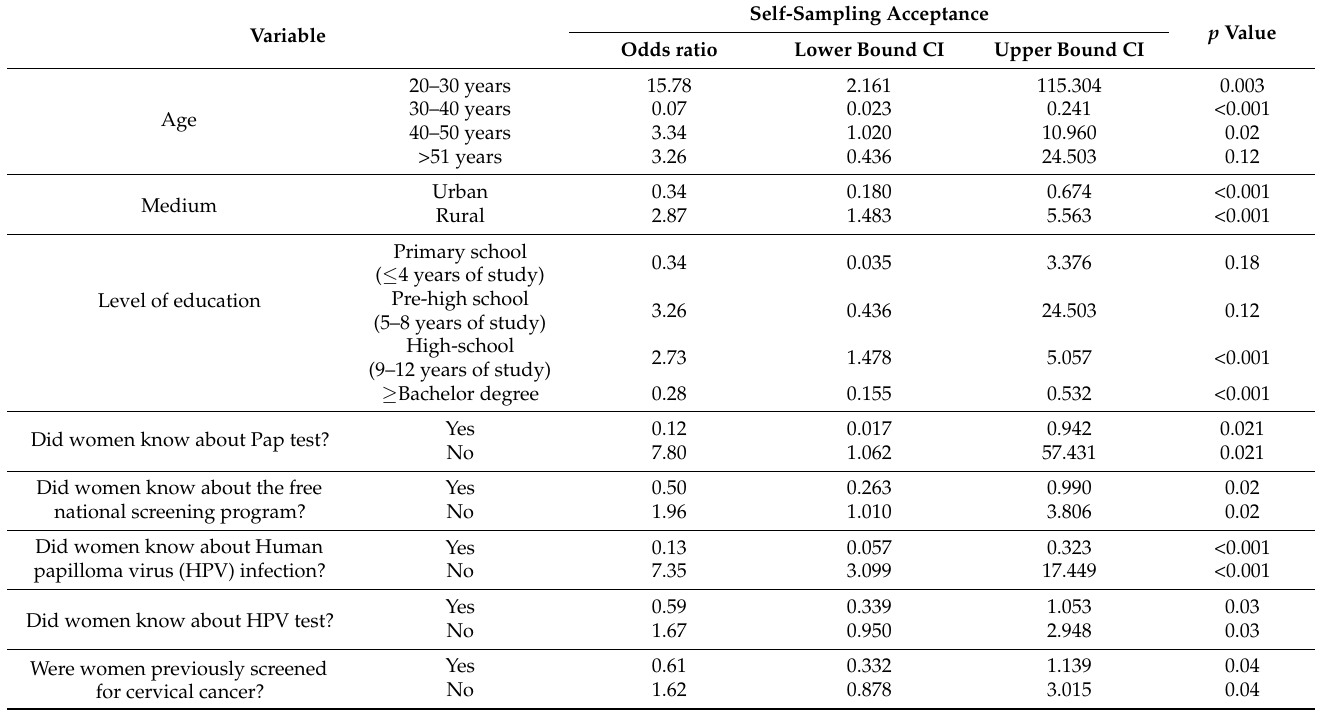
Table 3. Multivariate logistic regression analysis to identify factors associated with the acceptability of HPV